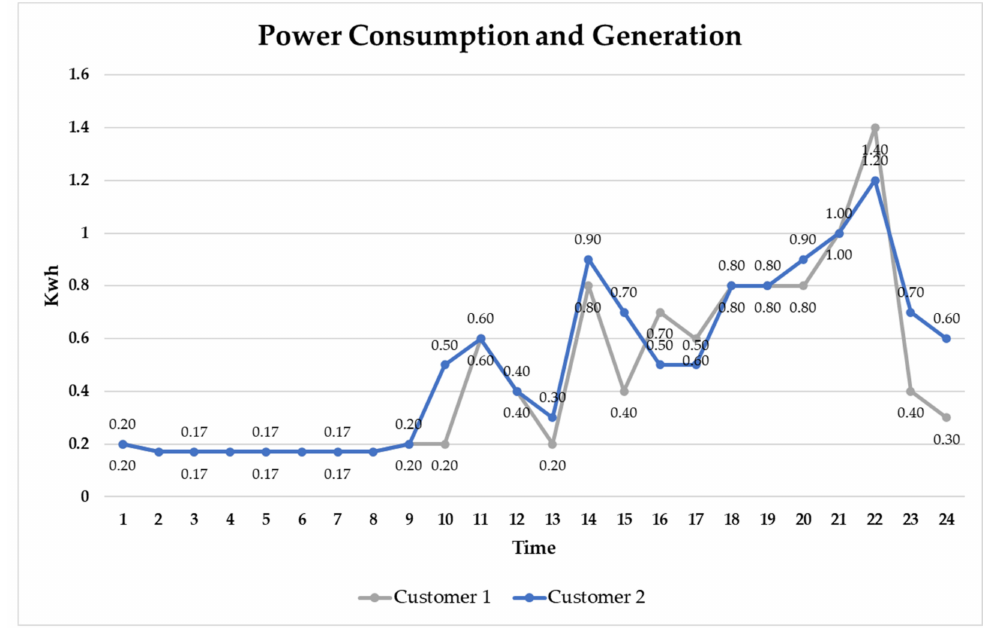
Figure 10. Consumption patterns of Customers 1 and